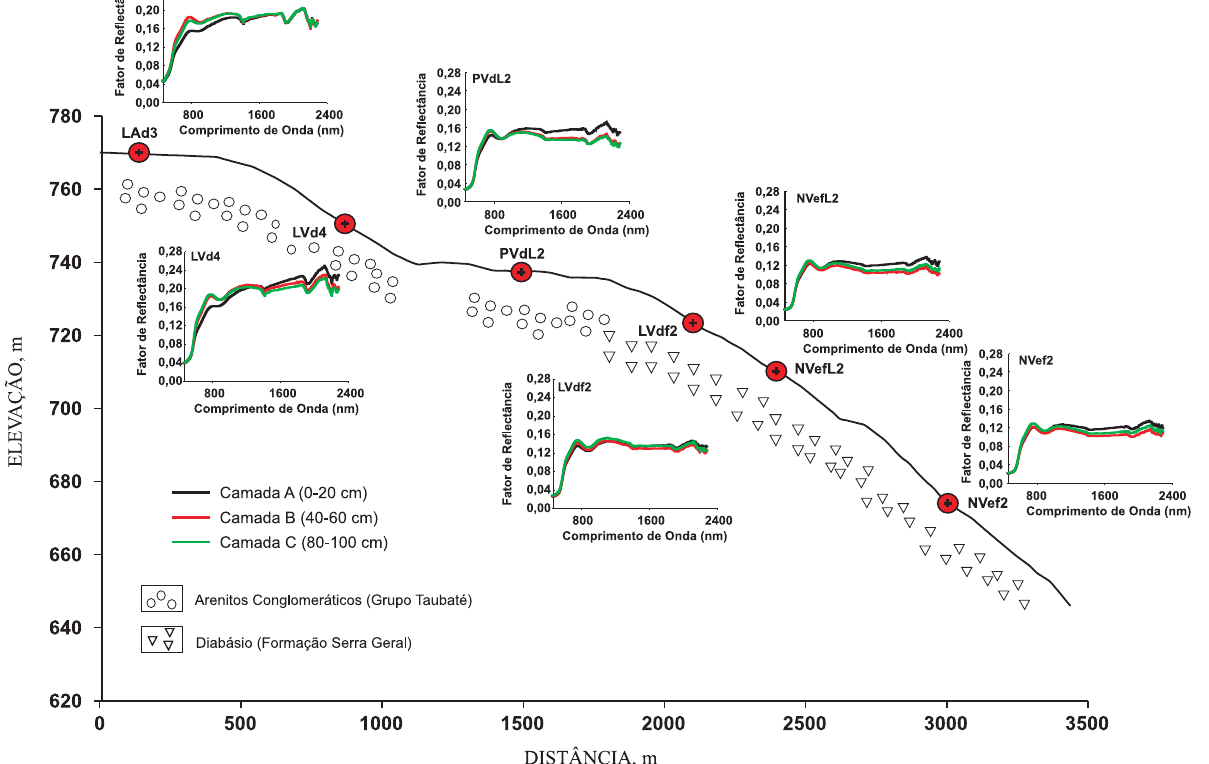
Figura 1. Variabilidade longitudinal e curvas espectrais dos solos em diferentes camadas na toposseqüência 1 da área de